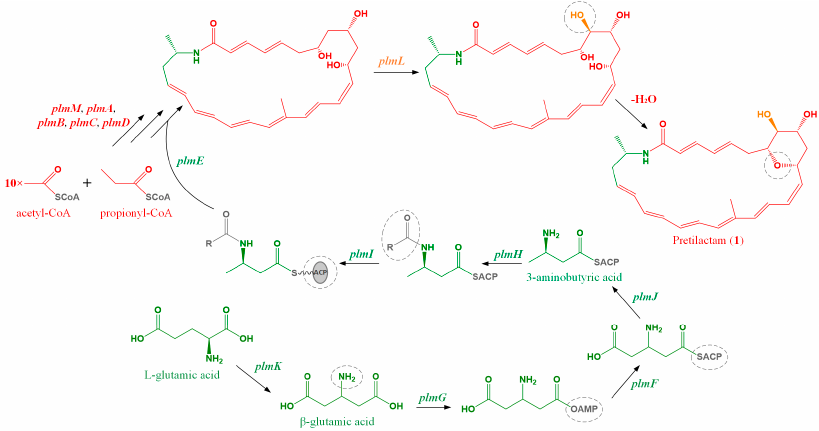
Figure 4. The plausible biosynthetic pathway of pretilactam ( 1 ).